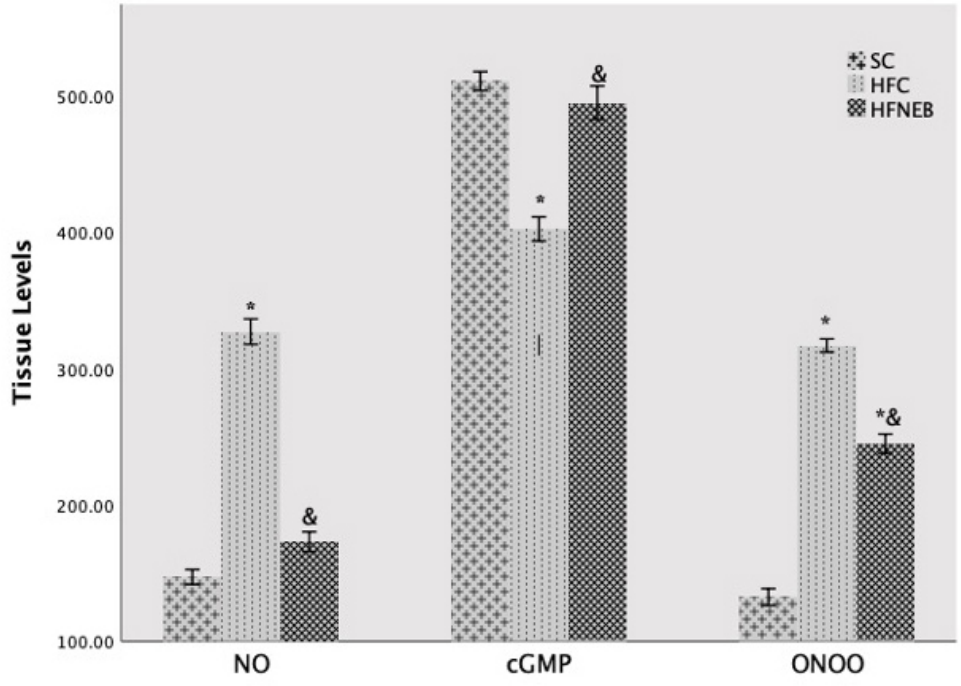
Fig. 5. Tissue NO, ONO 2 − and cGMP levels . Compared to SC group, HFC group of animals were characterized increased NO and ONO 2 − levels together with decreased cGMP. On the contrary, nebivolol treatment reduced the tissue NO, ONO 2 − levels and prevented the reduction in cGMP levels ( p < 0.05 *compared to SC, & compared to